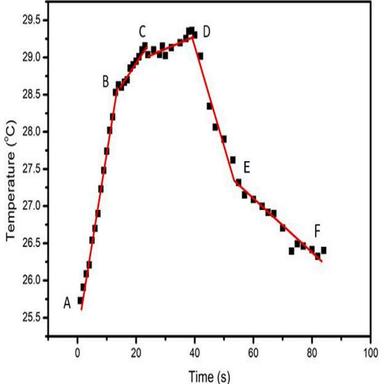
Transverse thermal field.